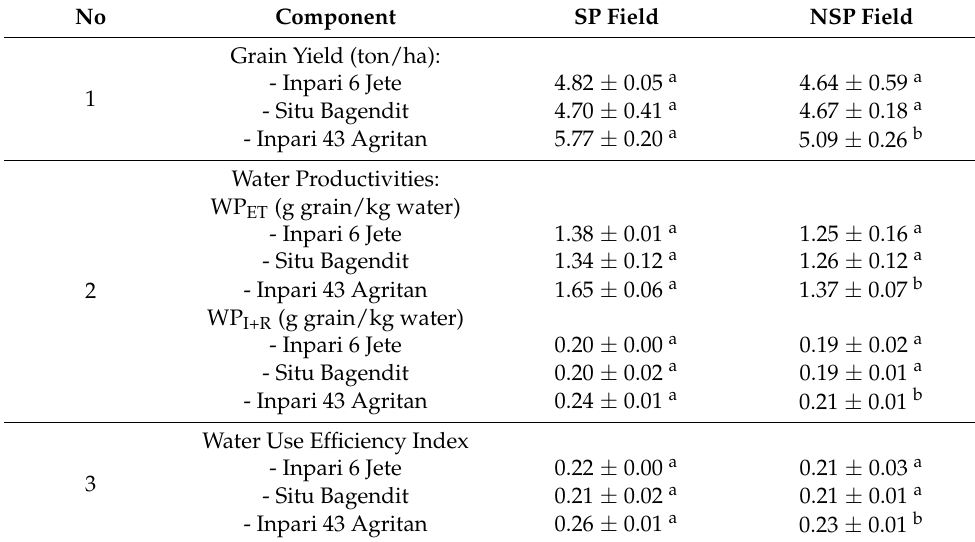
Table 3. Productivity, water productivity, and water use efficiency index of three rice varieties in the SP field and the NSP field. No Component SP Field NSP